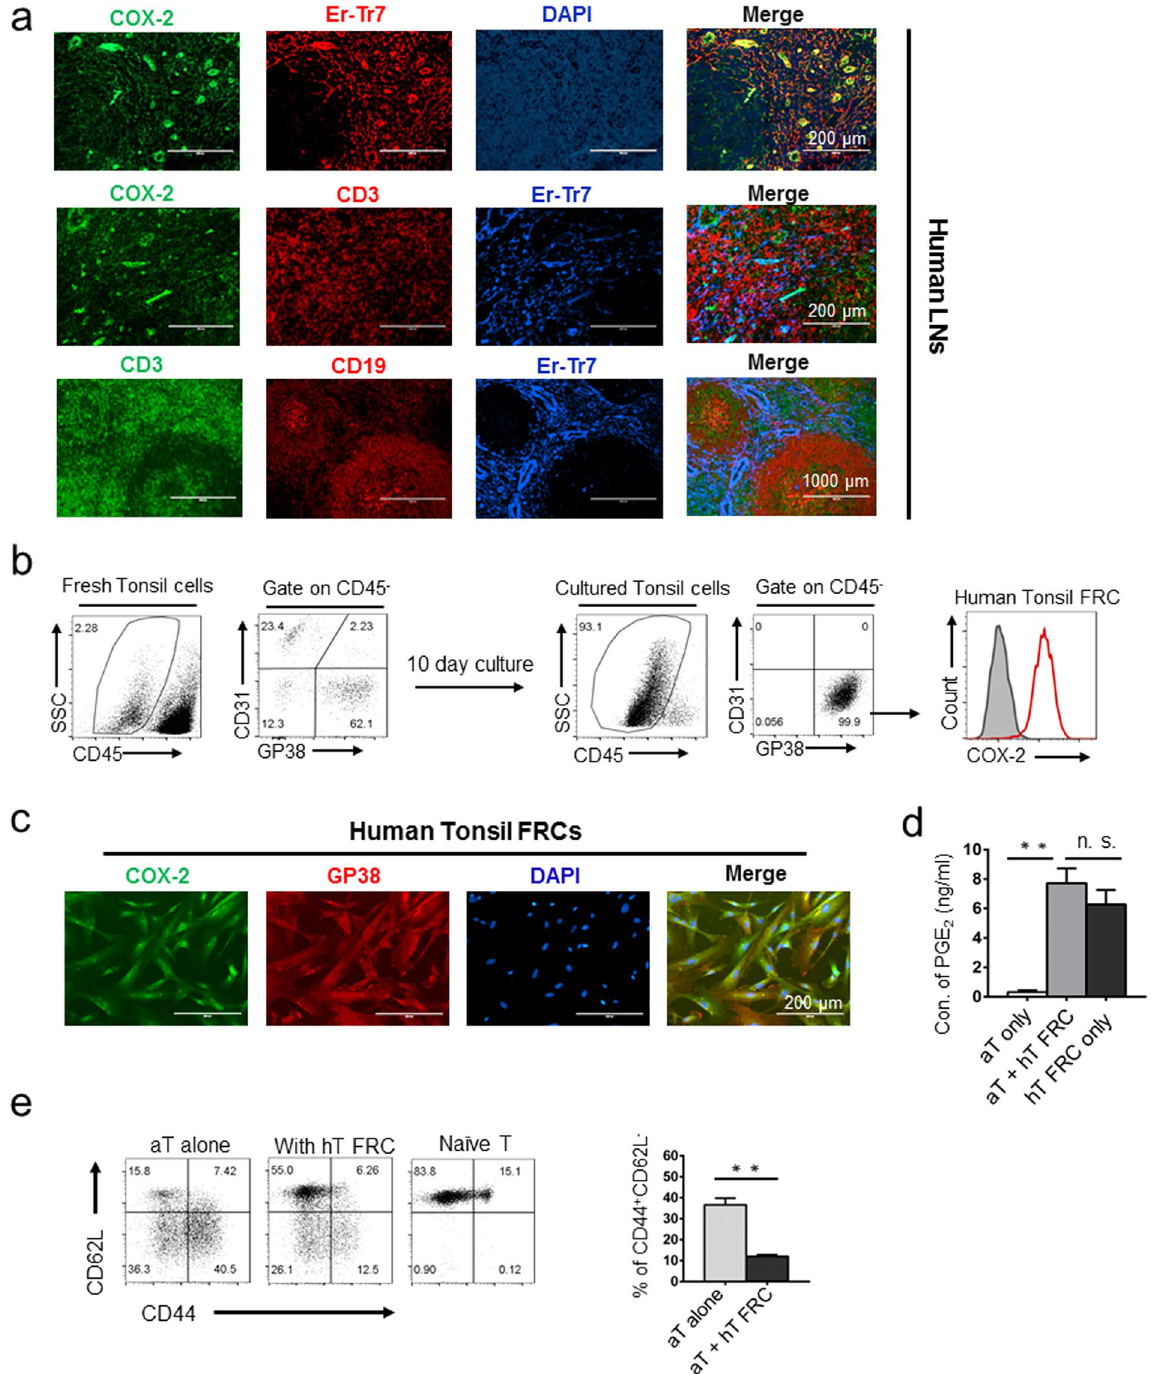
Figure 7. COX-2/PGE 2 hyperactivity is implicated in fresh-FRCs of human lymphoid tissues. ( a ) Microscopy examination of COX-2 expression and distribution in a normal human lymph node. Scale bars, 200 μ m (top two rows) and 1000 μ m (bottom row), respectively. ( b ) FRCs in freshly isolated and cultured human tonsils as CD45 − GP38 + CD31 − cells were confirmed via flow cytometry analysis. COX-2 expression in FRCs was confirmed via FACS analysis following intracellular staining (gray histogram, isotype control). ( c ) Immunofluorescence staining of COX-2 (green), GP38 (red) and DAPI (blue) for cultured human FRCs from human tonsils. Scale bars, 200 μ m. ( d ) PGE 2 produced by the T cells or human tonsil FRCs was analyzed via ELISA. ( e ) Naïve CD8 T cells from WT mice were stimulated by anti-CD3/28 beads in the absence or presence of human FRCs from tonsils. T cell activation status was determined by the expression of CD62L and CD44 via FACS analysis. ** P < 0.01, nonparametric Mann-Whitney test. Data are representative of two to three independent experiments with three replicates each. Error bars depict mean ±